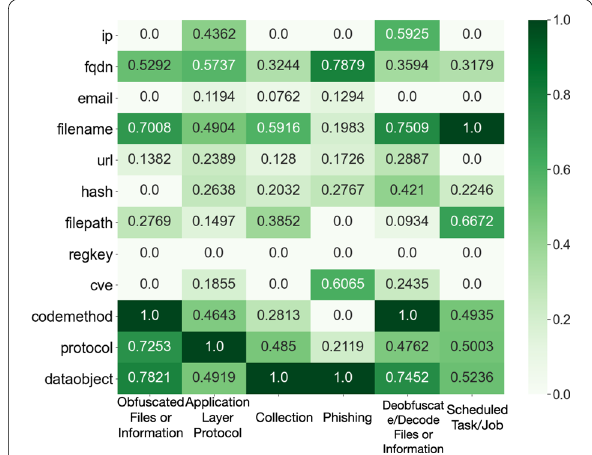
Fig. 2 Heat map of TTP elemental correlation coefficients. The vertical axis is the TTP element, and the horizontal axis is the TTP category. The correlation coefficients are normalized and take values between 0 and 1. A correlation coefficient closer to 0 indicates a weaker relationship between the element and the TTPs, and a correlation coefficient closer to 1 indicates a stronger